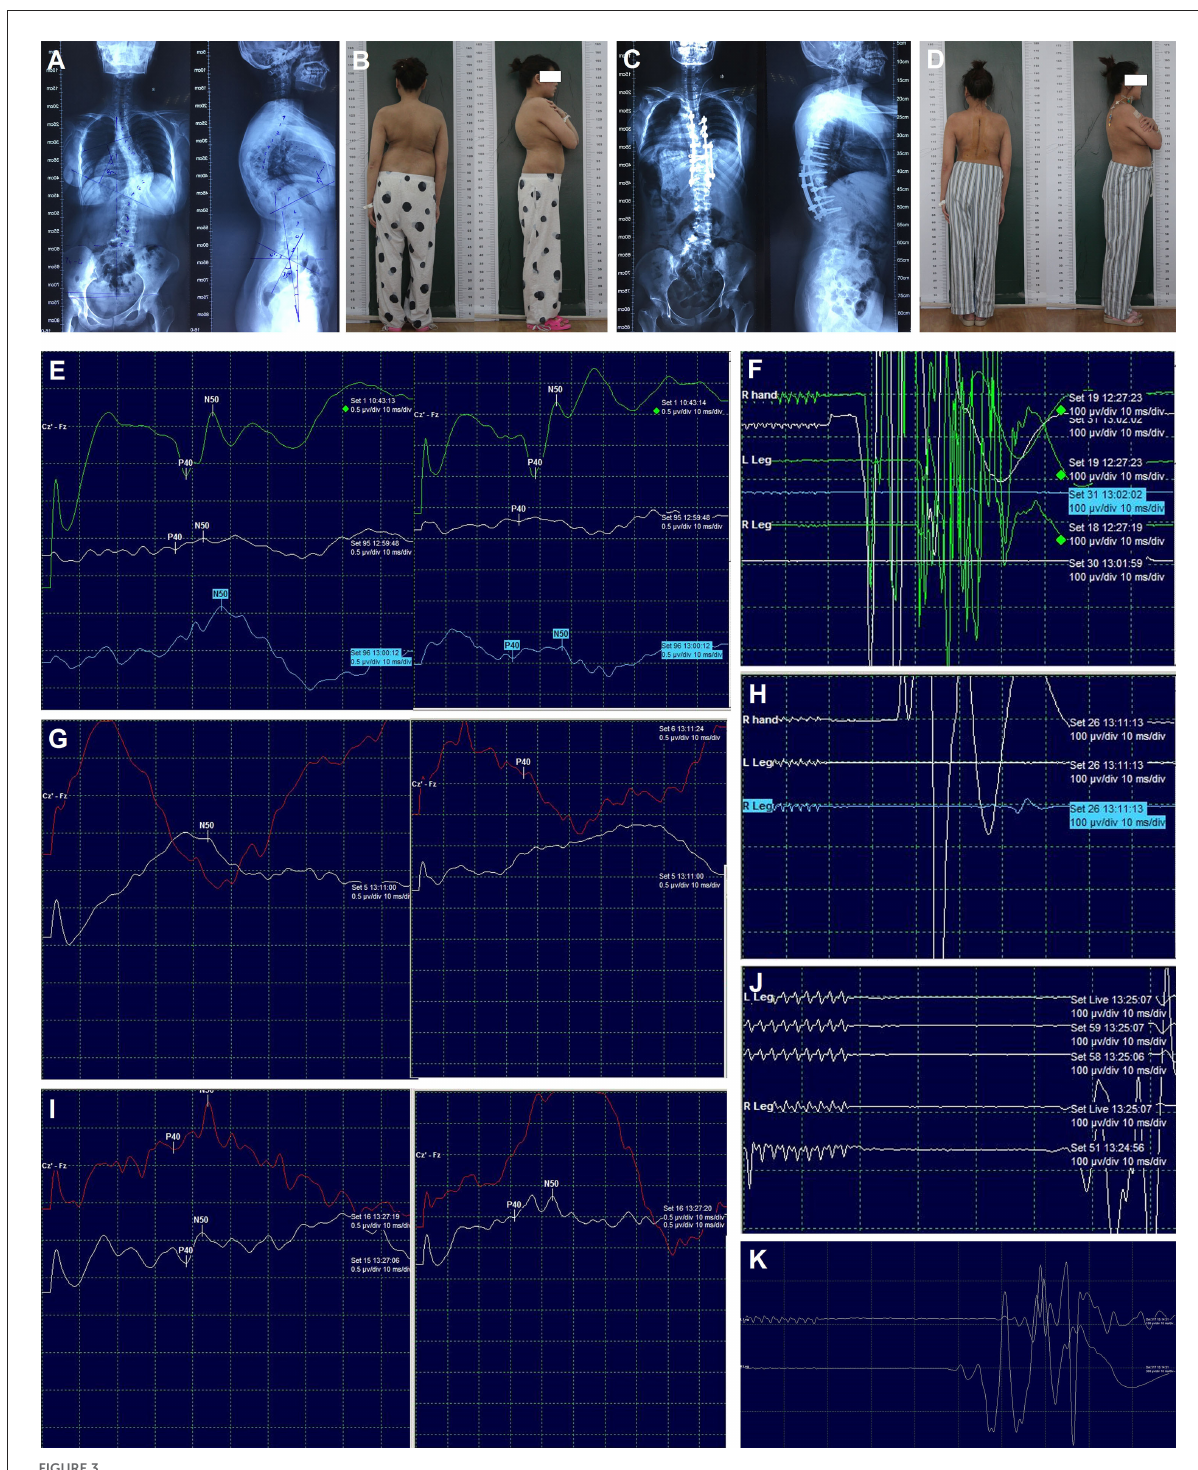
FIGURE3 Radiography, appearance, and intraoperative neurophysiological monitoring of case 2. Preoperative radiography of the entire spine (A) , preoperative appearance in the posterior and lateral views (B) , post-operative radiography of the entire spine (C) , post-operative appearance in the posterior and lateral views (D) . SEPs (E) and MEPs (F) after correction; SEPs (G) and MEPs (H) after spinal cord transposition immediately; SEPs (I) and MEPs (J) 15min later after spinal cord transposition; MEPs (K) at the end of surgery. MEPs: Motor-evoked potentials; SEPs: Somatosensory-evoked